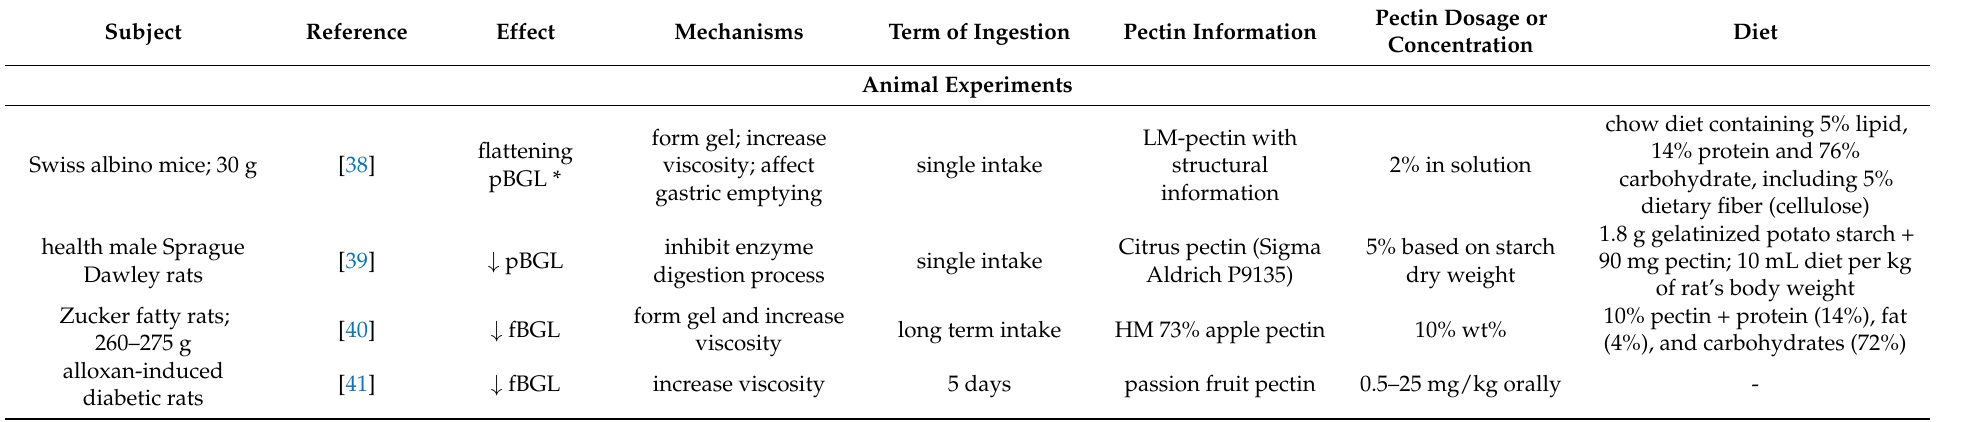
Table 2. Effects and mechanisms of pectin on postprandial and fasting blood glucose levels with animal